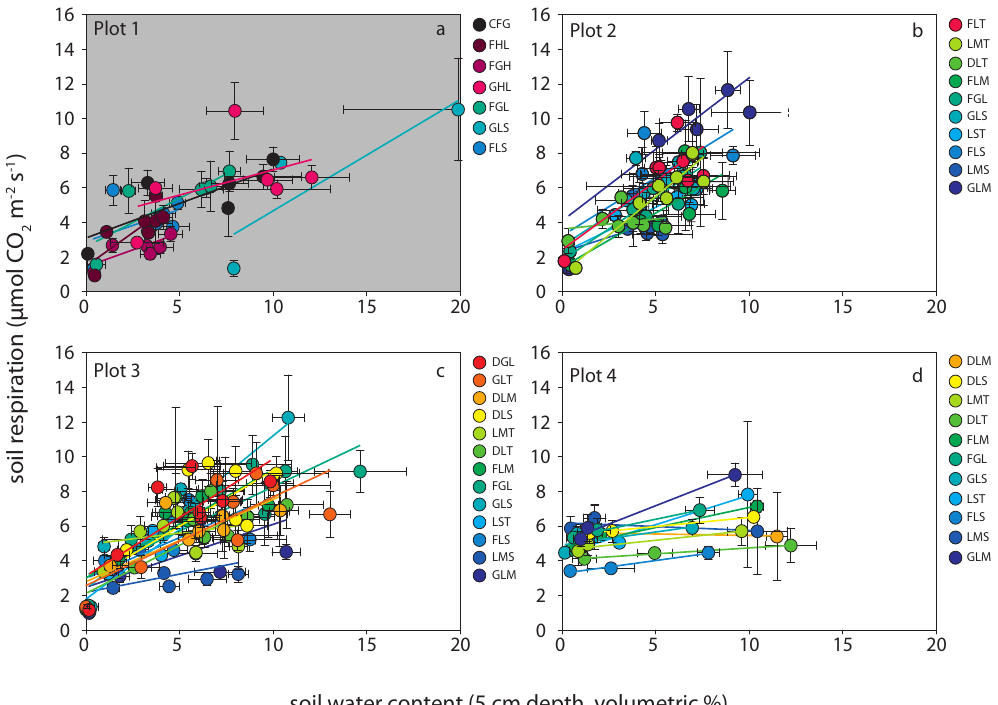
Fig. 2. Relation of R soil , measured during the field campaigns 2008 and 2009, plotted against soil water content ( θ) at a depth of 5cm along the disturbance gradient for each subplot (coloured) and plot. Similar categories are represented by the same color. Detailed information on categorized subplots and statistics are given in Tables 1 and 2. Table 4. Statistics and coefficients of the general linear model, in- cluding soil temperature and soil water content as primary factors influencing soil respiration on temporal time scales are given. n gives the amount of data available for each plot, p the significance level and c , d , h and i the plot specific coefficients. Grey highlighted is the disturbed plot.